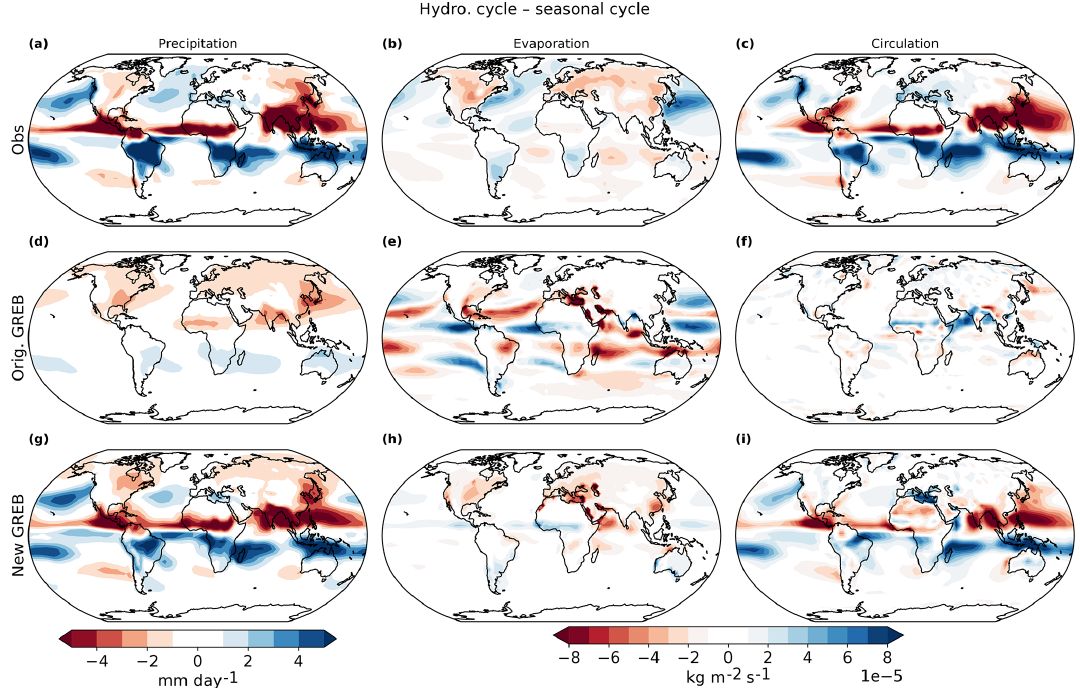
Figure 3. As Fig. 2 but for the seasonal cycle (DJF–JJA). The decomposition of the hydrological cycle into its parts: precipitation in mmday − 1 (a, d, g) , evaporation (b, e, h) and circulation in kgm − 2 s − 1 (c, f, i) in observations (a, b, c) , the original GREB model (d, e, f) and the new GREB model (g, h, i) for the seasonal